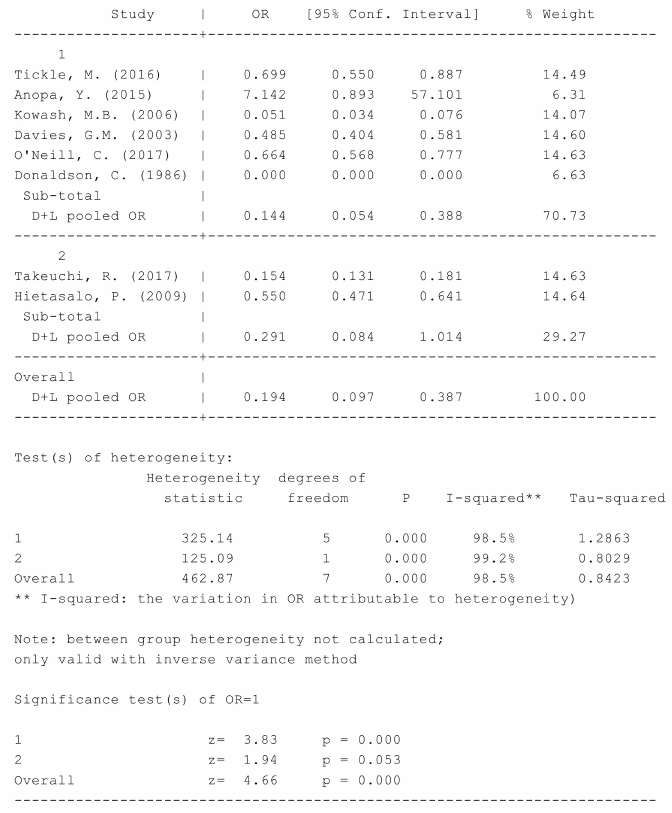
Figure A3. STATA do-file for analysis of Figure 4. “metan DMFTintervention NIntervention DMFTcontrol Ncontrol, label (namevar = Author, yearvar = year) by (age) random or”